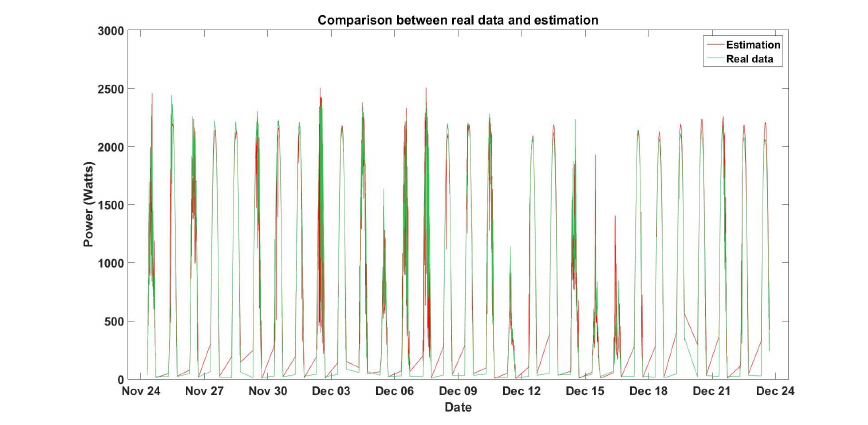
Figure 8. GDO results from HS.